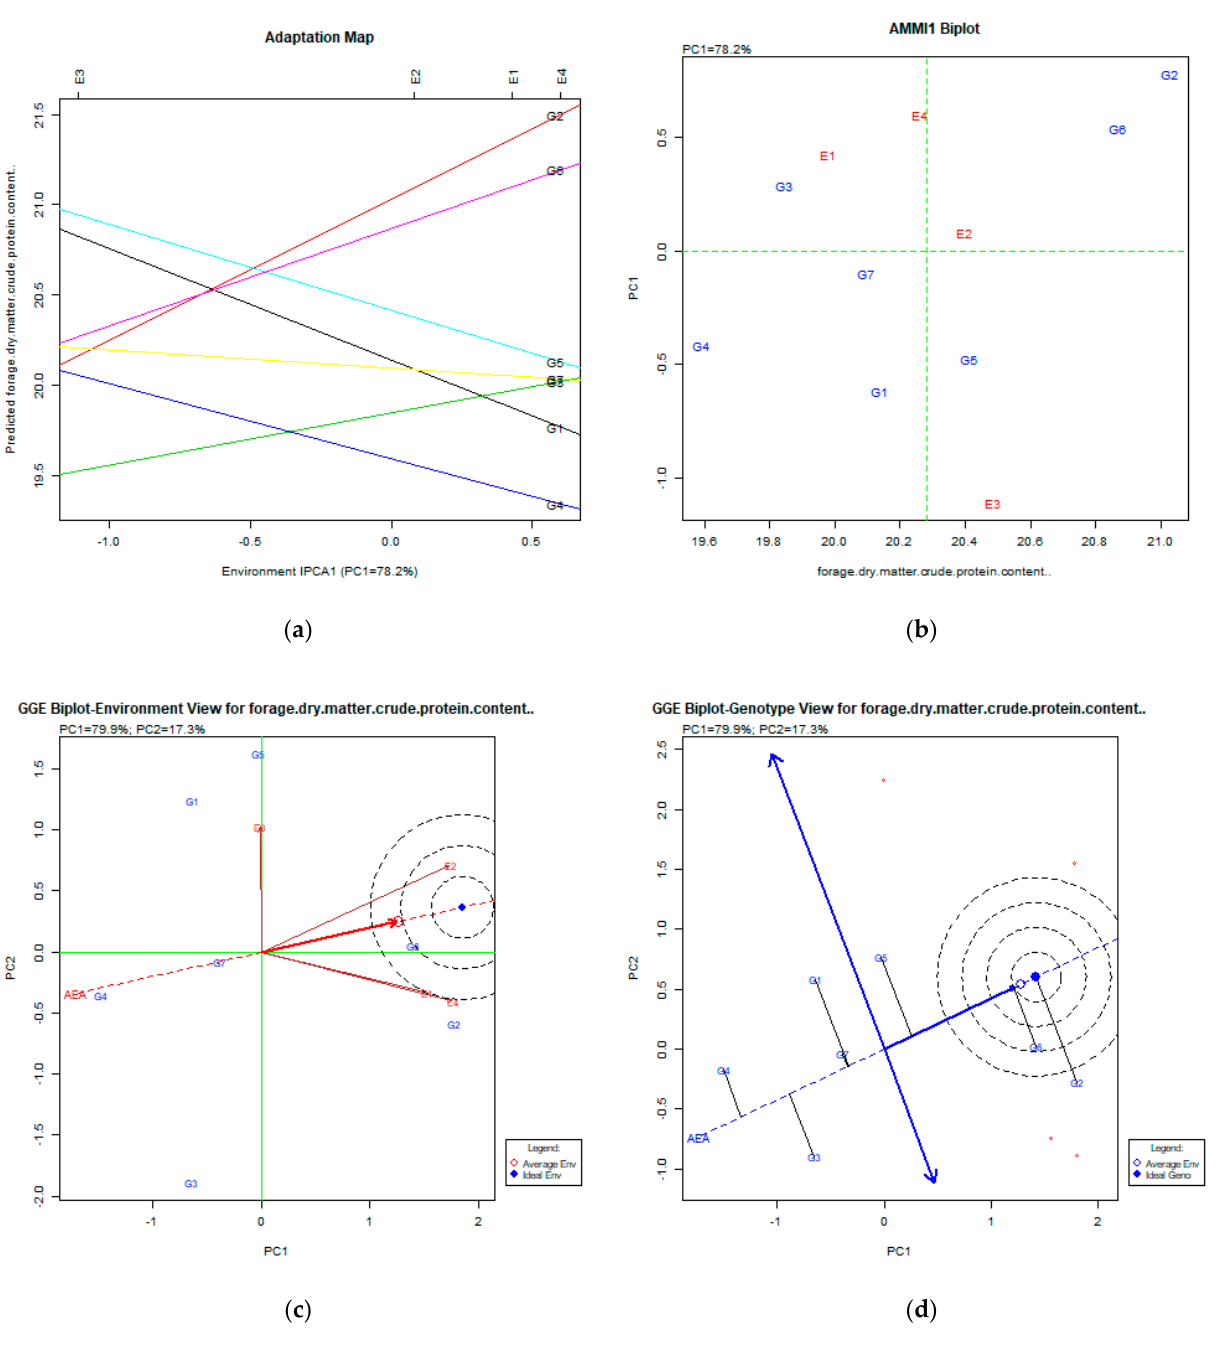
Figure 6. Stability analysis for the trait of forage dry matter crude protein content % based on: ( a ) adaptation map, where the environmental stability of the genotypes is visualized by the X − axis (PC1) and the performance of the trait for the genotypes is tested by the Y − axis; ( b ) AMMI1 biplot, where the environmental stability of the genotypes is visualized by the X − axis (PC1) and the per- formance of the trait for the genotypes is tested by the Y − axis; ( c ) GGE biplot depicting the environ- mental stability over time for the desirable genotypes placed near the ideal environment; ( d ) GGE biplot for genotypes depicting the genotypic stability in different environments. The desirable gen- otypes are those placed near the concentric region of the ideal genotype.